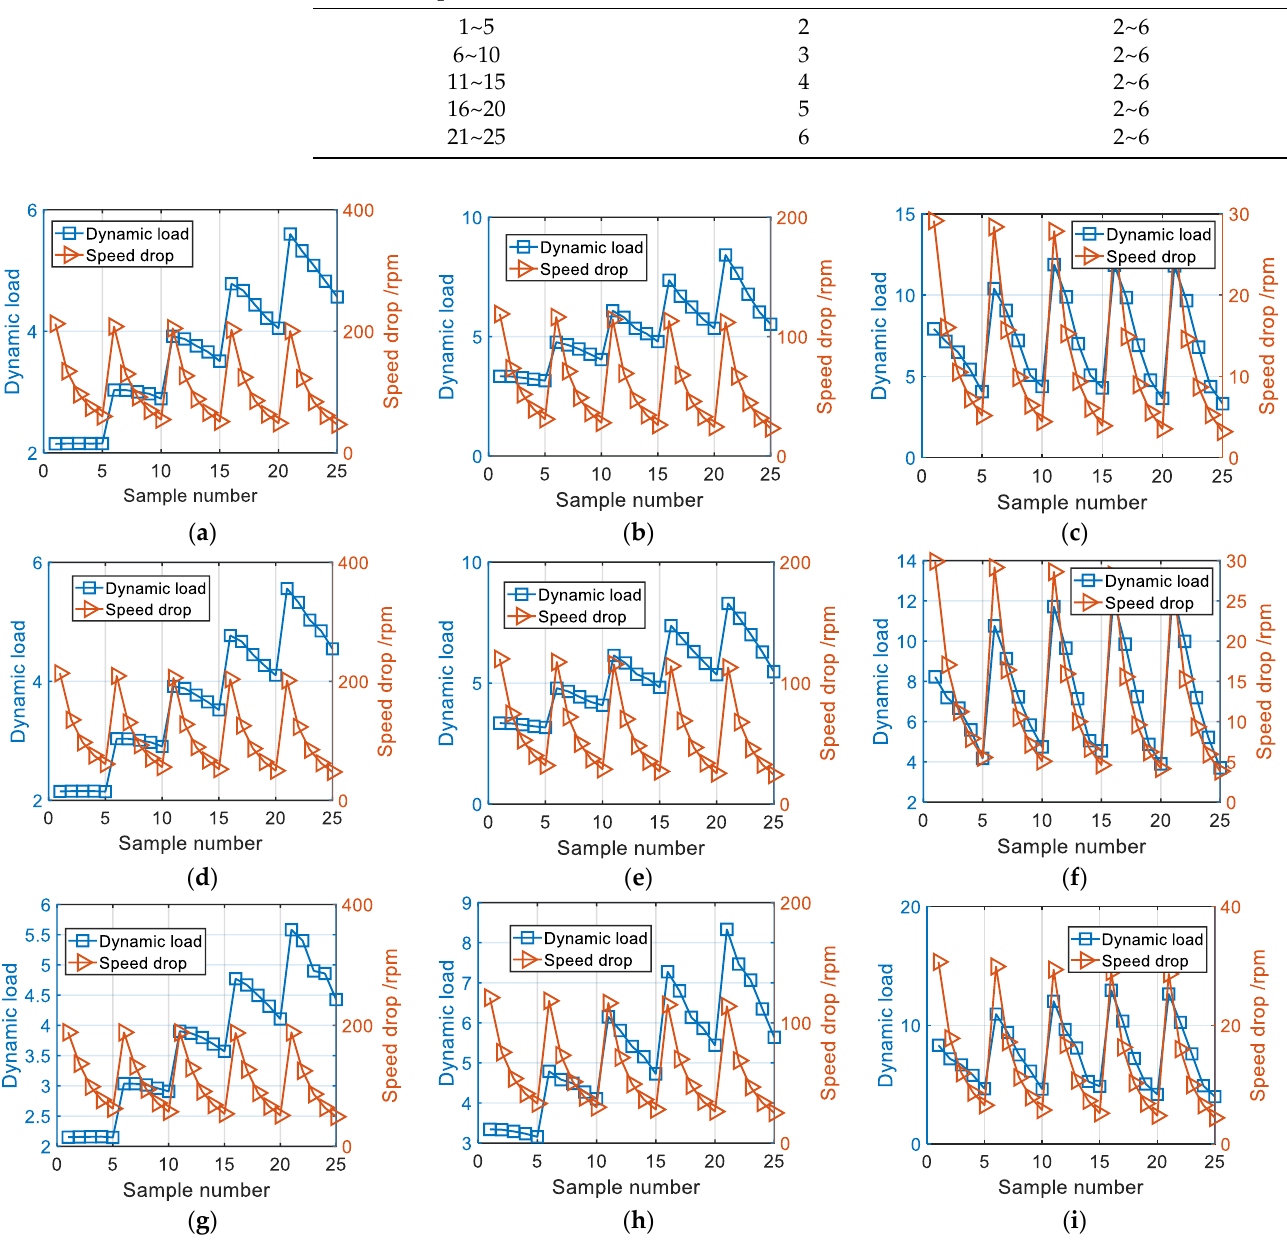
Figure 6. Full-factorial simulation test results: ( a ) High-speed and large-load working condition; ( b ) high-speed and medium-load working condition; ( c ) high-speed and small-load working condition; ( d ) medium-speed and large-load working condition; ( e ) medium-speed and medium-load working condition; ( f ) medium-speed and small-load working condition; ( g ) low-speed and large-load working condition; ( h ) low-speed and medium-load working condition; ( i ) low-speed and low-load working condition.